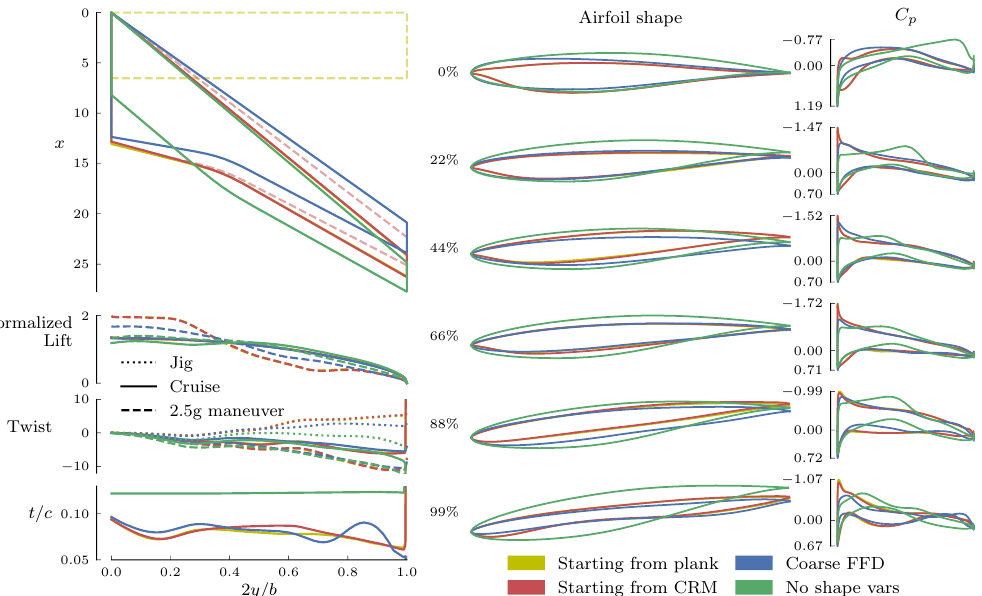
Figure 11. Comparison of single-point optimized designs. The optimizations starting from the plank and CRM planforms converge to nearly the same design.